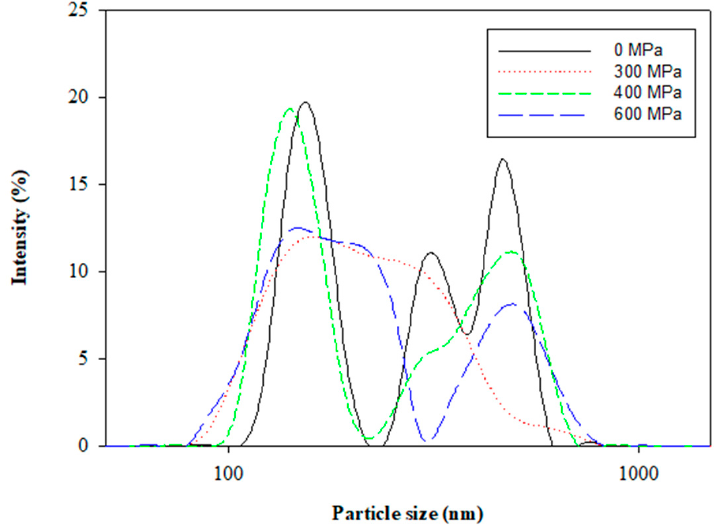
Figure 4. Size distribution of Clitoria ternatea petal extract-loaded liposomes prepared at different pressures by the HPP method.